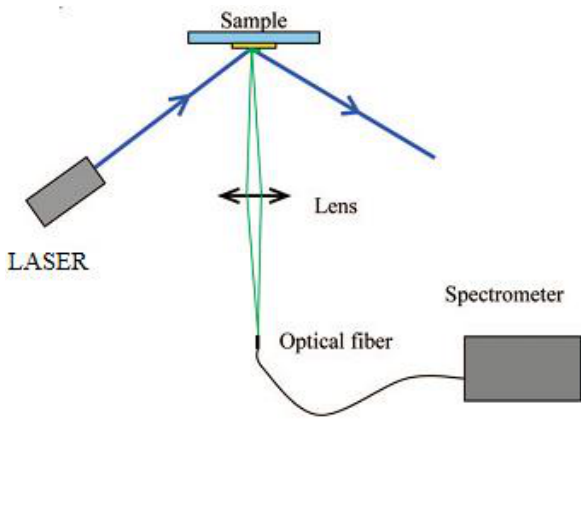
Figure 1. Photoluminescence recording